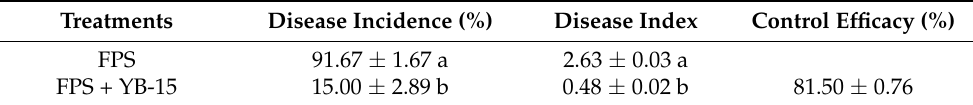
Figure 3. Effect of strain YB-15 against Fusarium crown rot caused by F.pseudograminearum and on growth of wheat seedlings: ( A , E ) seeds soaked with YB-15 and planted in sterile soil without pathogen inoculum; ( B , F ) seeds not soaked with YB-15 and planted in sterile soil without pathogen inoculum; ( C , G ) seeds soaked with YB-15 and planted in sterile soil with pathogen inoculum; ( D , H ) seeds not soaked with YB-15 and planted in sterile soil with pathogen inoculum. Table 1. Disease index, disease incidence and control efficacy of B. subtilis YB-15 against Fusarium crown rot of wheat.